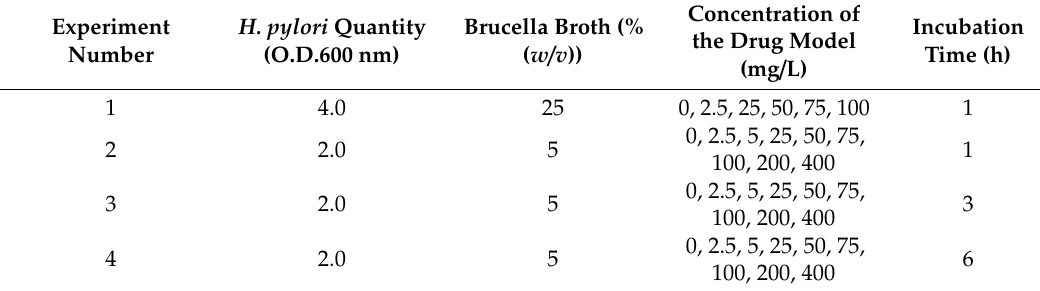
Table 1. Composition of the incubation mixture, containing H. pylori 26,695 strain, brucella broth, and a peptide-based drug. The incubation period (at 37 ◦ C) of the mixture is also indicated. The experiments were conducted in